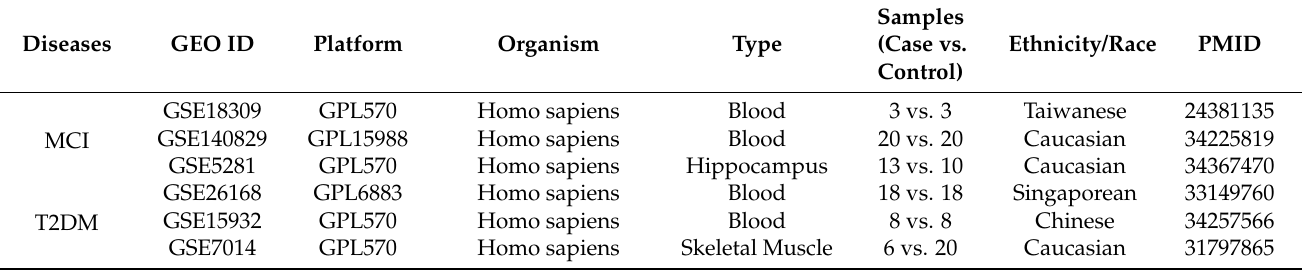
Table 1. Datasets